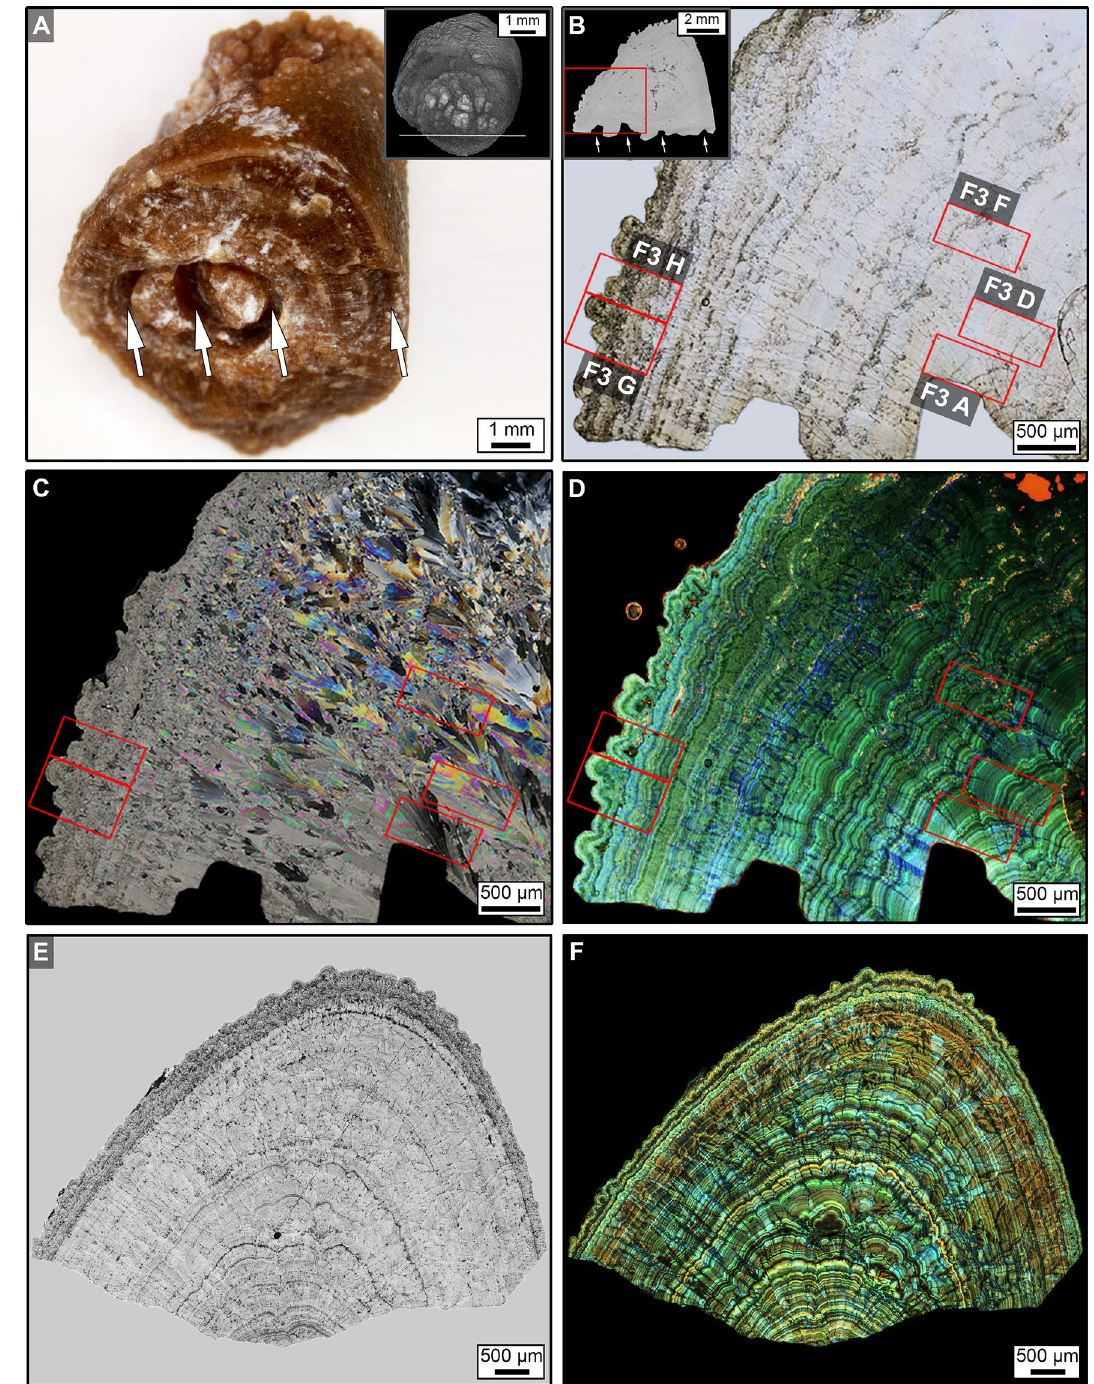
Figure 2. Three-dimensional (3D) external morphology of kidney stone fragment 106F3 and two-dimensional (2D) internal crystalline architecture of thin section 106F3-1 and 106F3-2. ( A ) 3D reflected light (RL) image of the entire stone showing notches (white arrows) resulting during PCNL SPL procedure. Weight data presented in Supplementary Table S1. Inset is a 3D computed tomography (CT) external surface rendering of entire stone from a different orientation showing the line of section (white line). Thin section 106F3-2 was prepared ~ 500 μm below the line of section. ( B ) Brightfield (BF) image of 2D virtual thin section 106F3-1 made at position shown in the line of section show in the inset of ( A ), exhibiting a complete history of earliest-to-latest stone growth crystallization. Red boxes indicate the locations of enlargements shown in Fig. 3. Inset is a 2D virtual CT cross-section taken through line of section shown in ( A ). White arrows show PCNL and SPL notches that correspond to ( A ), and red box indicated enlargement in ( B ). ( C ) Polarization (POL) image of ( B ). Red boxes indicate the location of enlargements shown in Fig. 3. ( D ) Tiled confocal autofluorescence (CAF) image of merged pseudo-colored red, green, and blue (RGB) channels indicate that the COM cortex (COM C ) is composed of nano-layering. Red boxes indicate the location of enlargements shown in Fig. 3. ( E ) T-PMT of thin section 106F3-2 exhibiting the original internal crystalline architecture of the PCNL-derived 106F3 stone fragment. ( F ) Tiled CAF image of merged pseudo-colored RGB channels of ( E